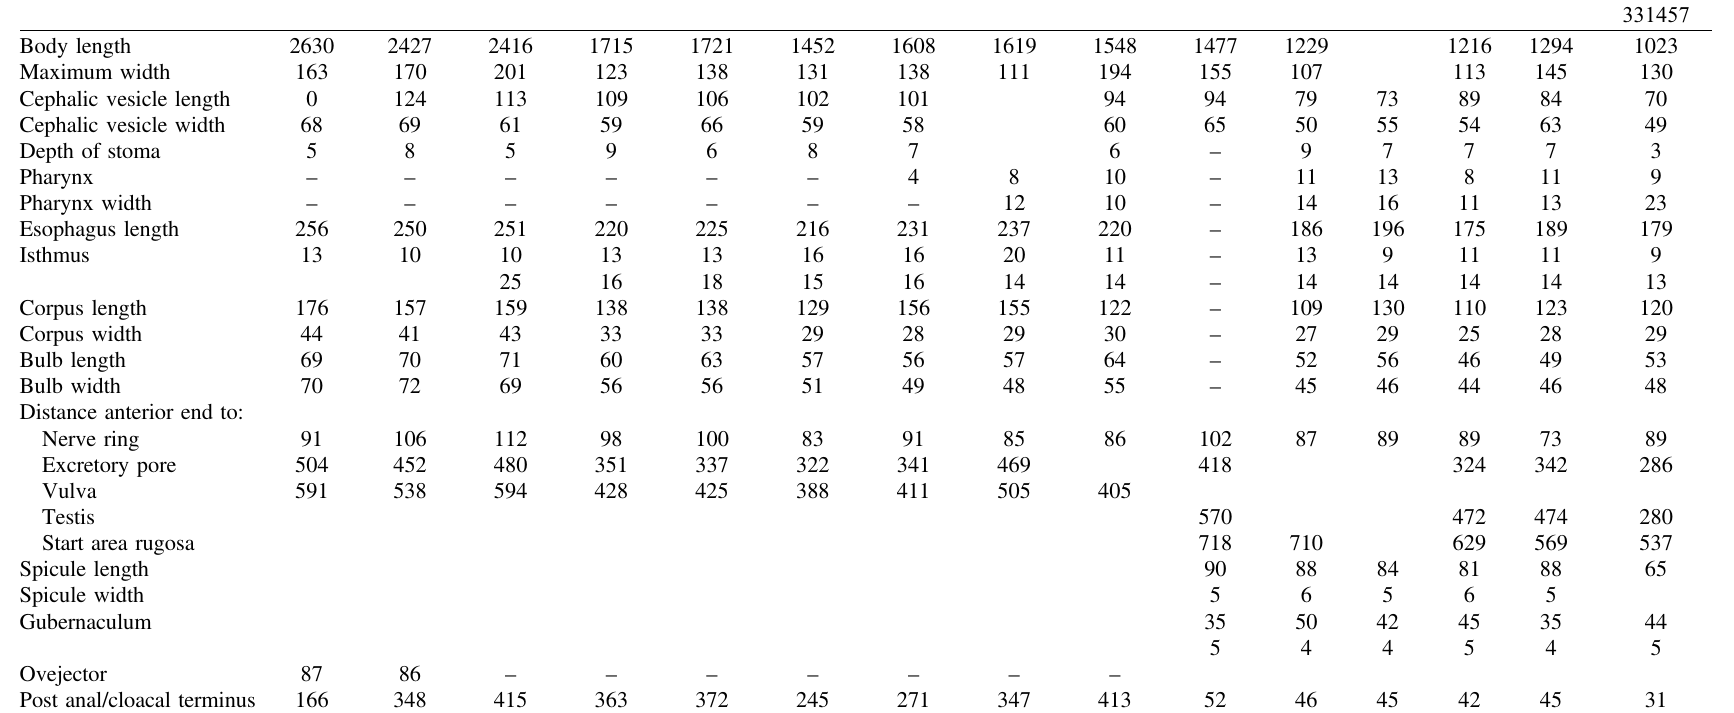
Table 2. Measurements of type specimens used in the characterization and description of Tlacuatzoxyuris simpsoni , parasite of the gray opossum Tlacuatzin canescens (Allen, 1893) endemic to Mexico. Specimens were collected in the locality of Cruz Pintada, Morelos (18 (cid:3) 27 0 58 00 N, 99 (cid:3) 2 0 16 00 W, 1016 m), with the exception of AMNH IZC 331457, Tlacuatzoxyuris sp., from